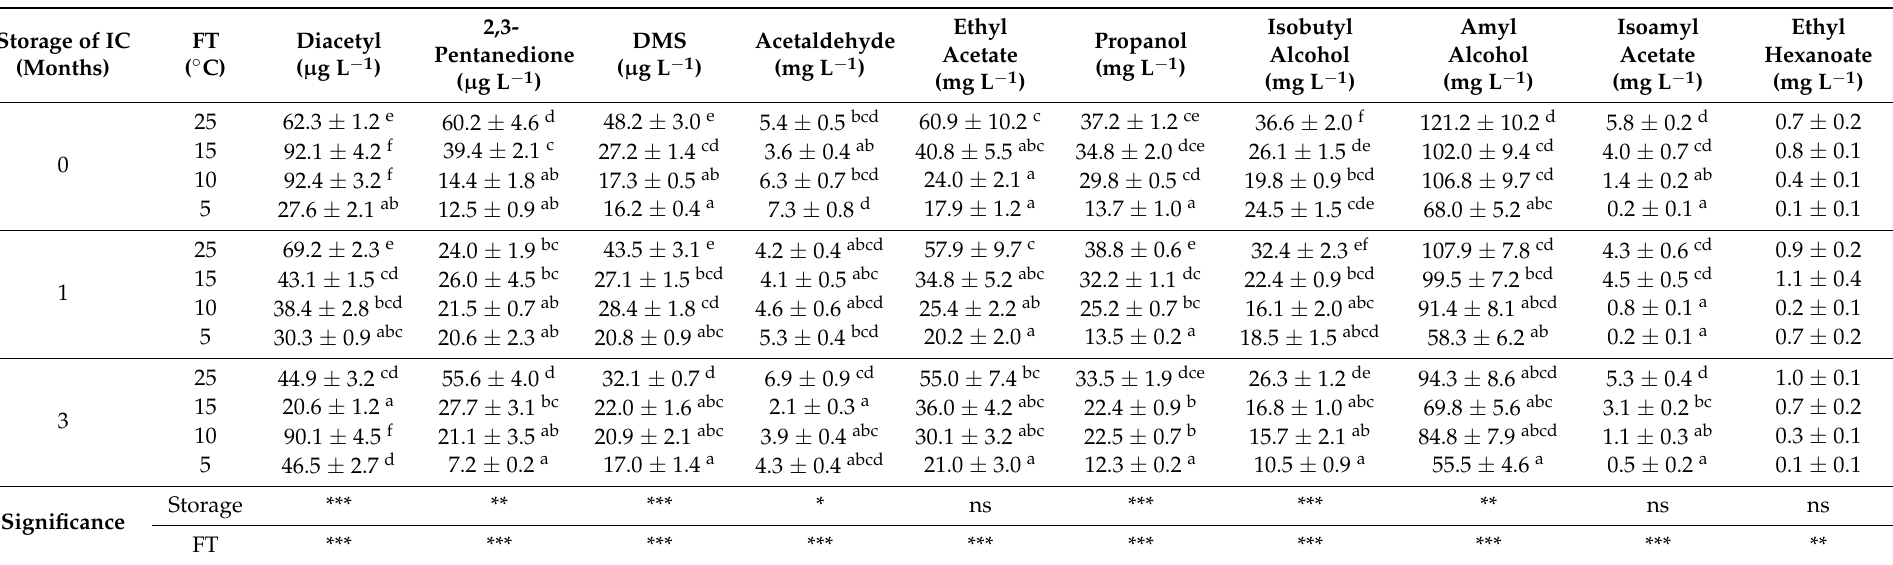
Table 2. Major volatile compounds in beers produced using thermally dried immobilized S. cerevisiae on peanut